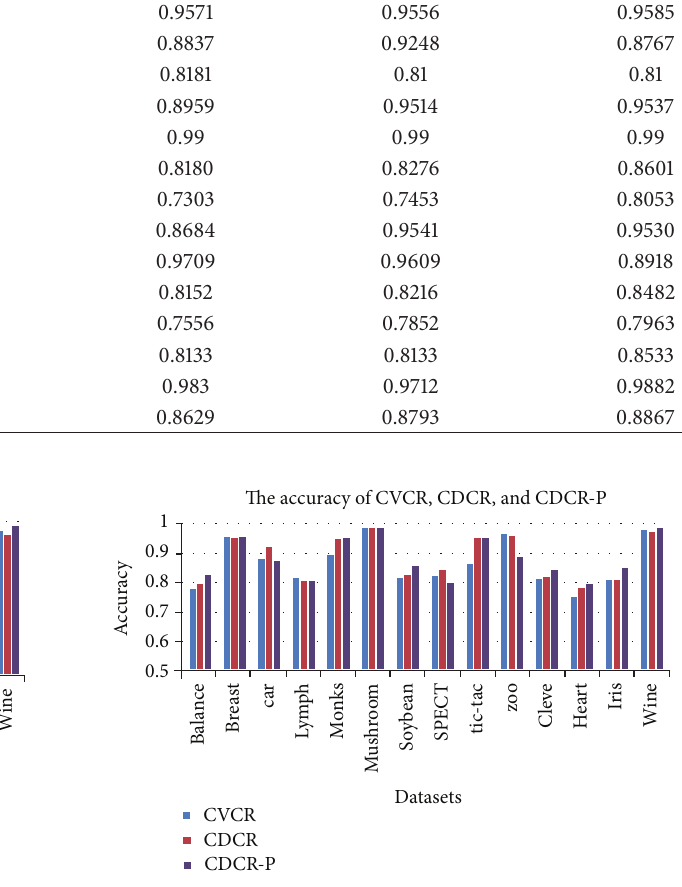
Figure 1: The accuracy of ID 3 , FOIL, and CVCR. Figure 2: The accuracy of CVCR, CDCR, and